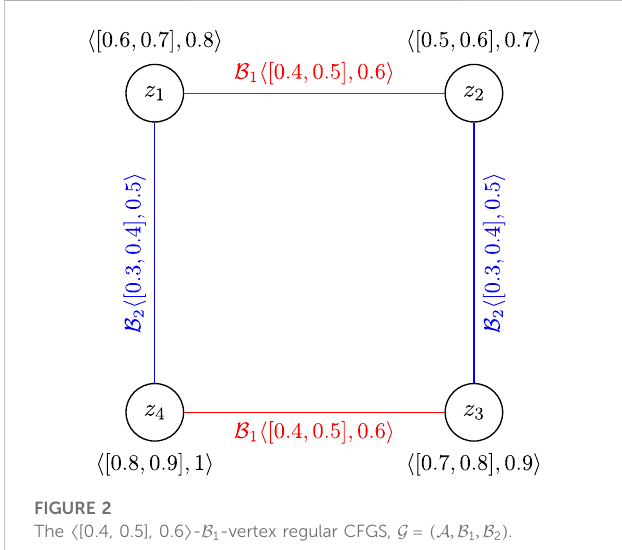
FIGURE 2 The 〈 [0.4, 0.5], 0.6 〉 - B 1 -vertex regular CFGS, G (cid:2) ( A , B 1 , B 2 )